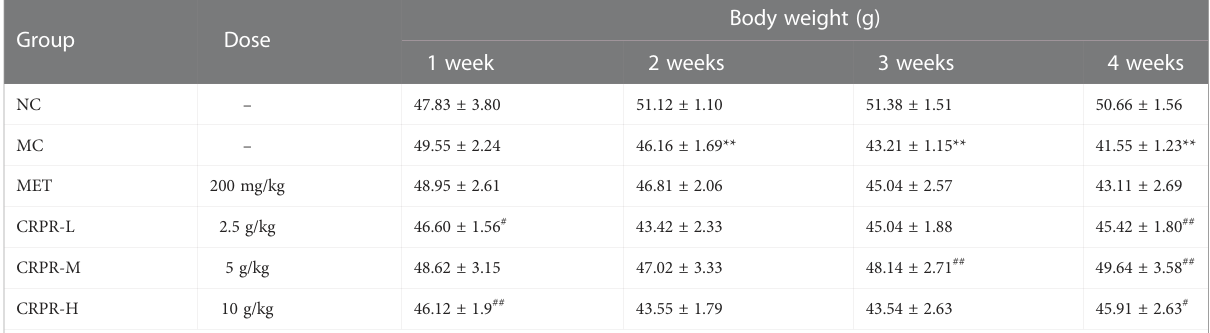
TABLE 1 Changes of body weight in T2DM